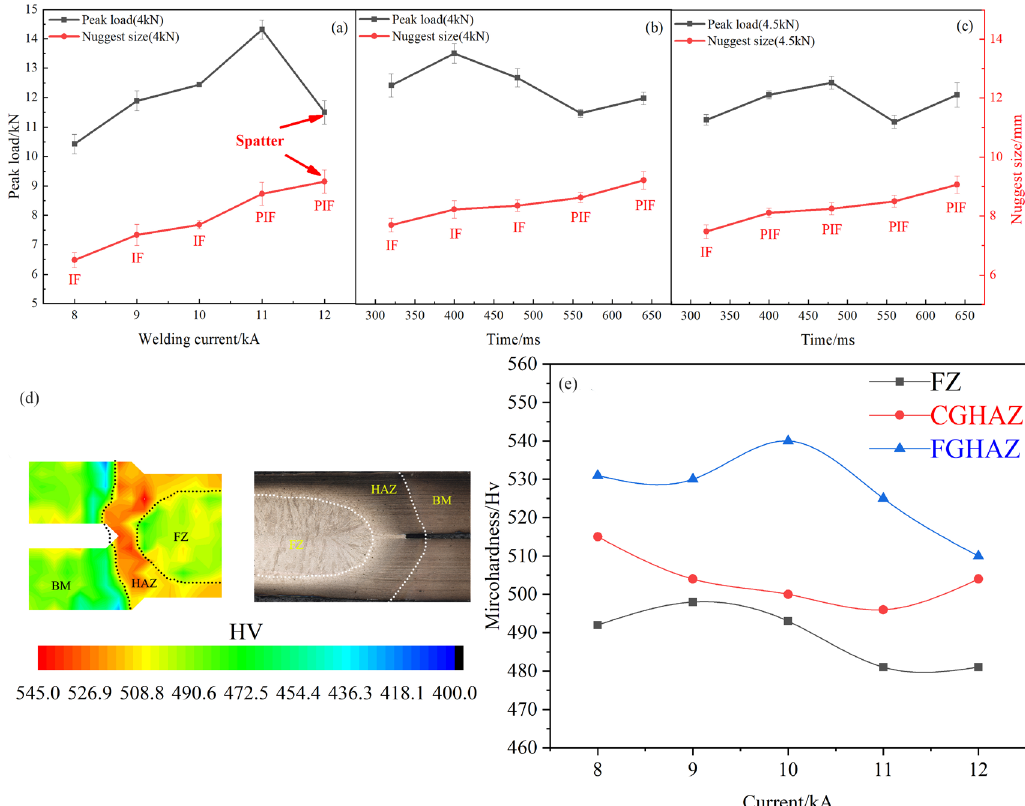
Figure 5. (a), (b), and (c) are the effects of welding current, welding time, and electrode force on peak load and nugget diameter, respectively; (d) microhardness distribution of solder joints at 10 kA; (e) hardness characteristics of each structural region of solder